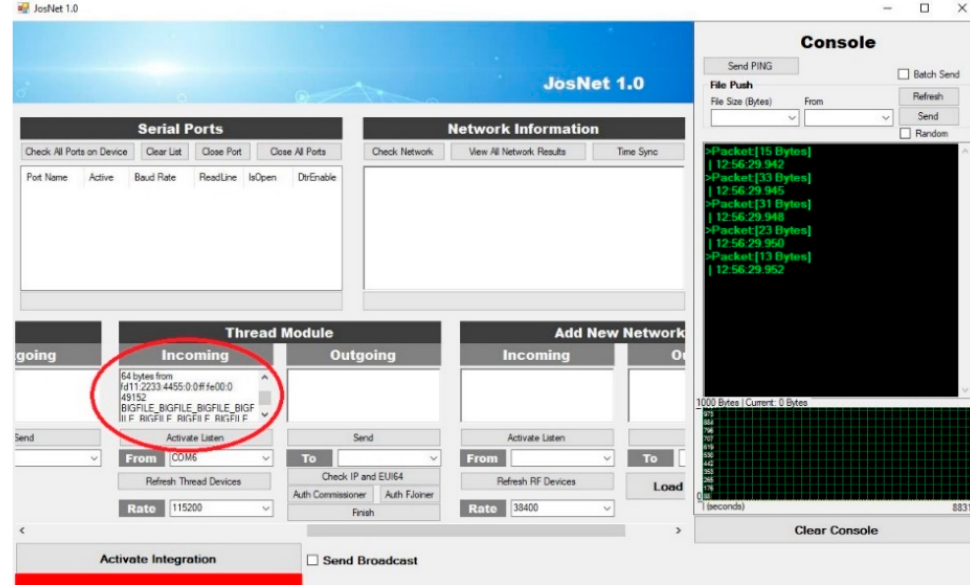
Figure 15. Thread device receives 64 bytes packet from Station 2.